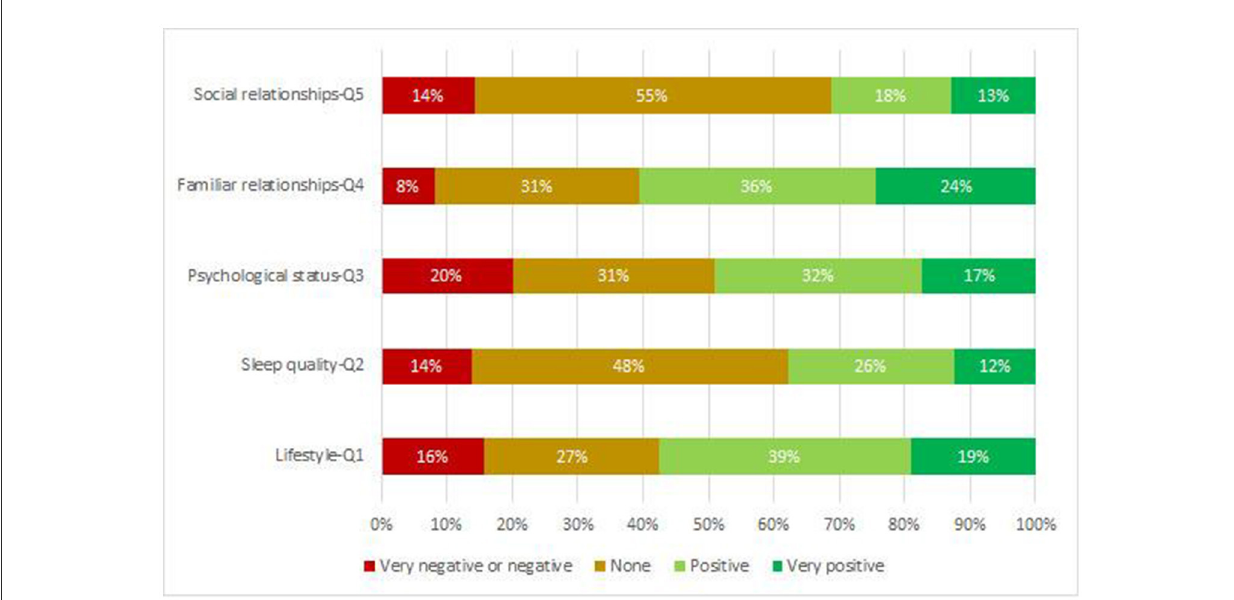
FIGURE1 Perception of the impact of WFH on: Q1- lifestyle, eating habits and state of health; Q2-quantity/quality and disturbances of sleep, and daytime sleepiness; Q3-psychological status; Q4-quality of interpersonal relationships within the family; Q5-quality of interpersonal relationships within the network of friends. Very negative and negative rates have been combined due to very low frequencies of the very negative rate.